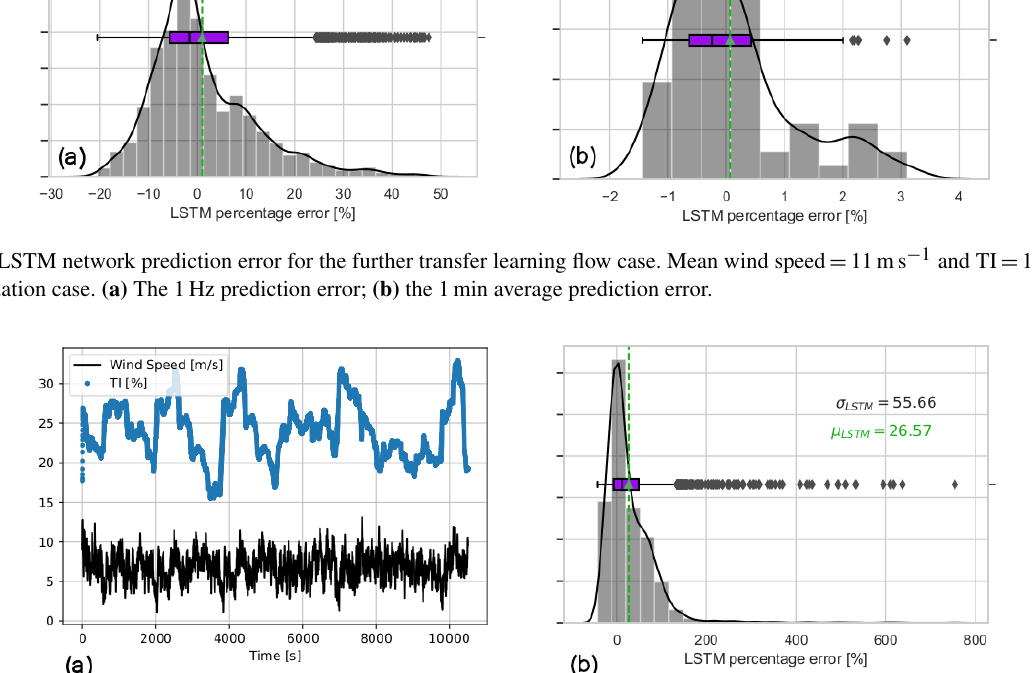
Figure 15. Input time series and 1min prediction error of the first LSTM network, higher-turbulence-intensity flow case. Mean wind speed = 7ms − 1 and TI = 20% over the 60min validation case. (a) Time series of the inflow dataset for the higher-TI test of the first LSTM network, originally trained on mean wind speed = 7ms − 1 and TI = 10%. (b) The 1min average percentage error of the first LSTM network tested under higher TI.